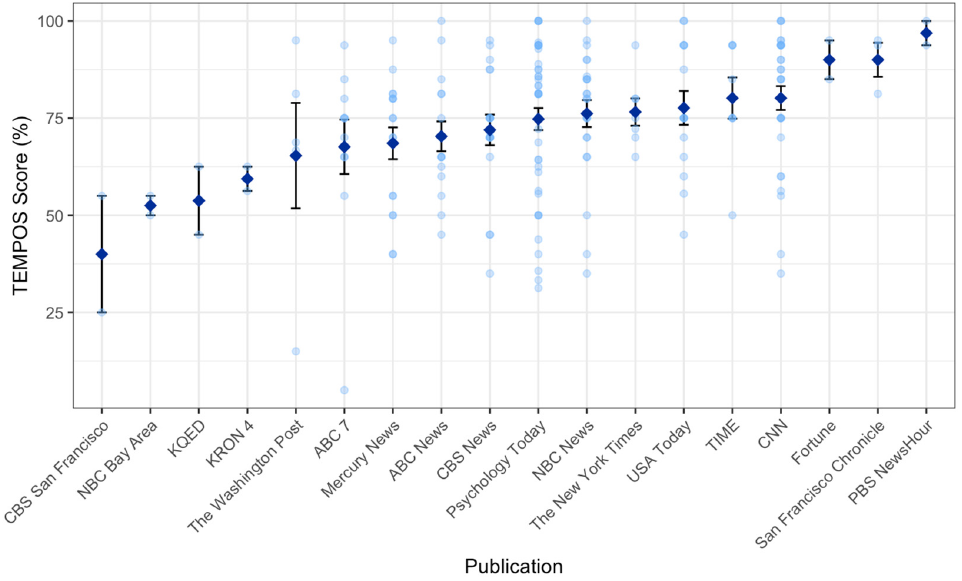
Figure 5. TEMPOS scores, sorted by publication. Each light blue point represents an article; dark blue diamonds indicate publication averages. Error bars represent standard error of the mean. Publications with less than 3 articles in the dataset were dropped from the plot.